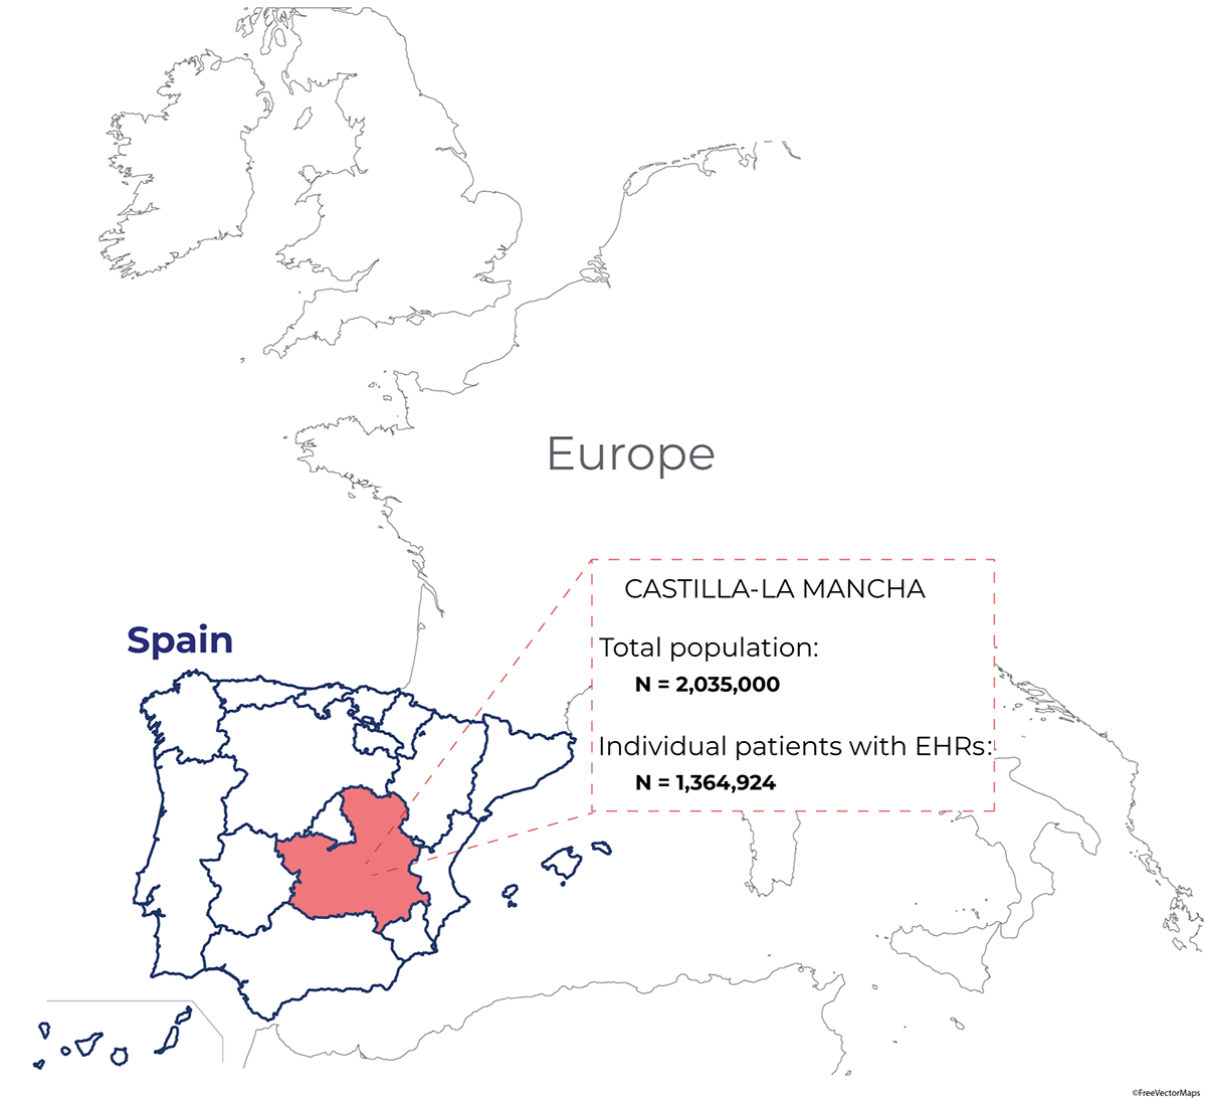
Figure 1. Map of the Castilla-La Mancha region (red) within the Spanish (blue line) and European territories. From a general source population of 2,035,000 inhabitants, we collected and analyzed the clinical information in the EHRs of 1,364,924 patients within the Servicio de Salud de Castilla-La Mancha (SESCAM) Health Care Network. EHR: electronic health